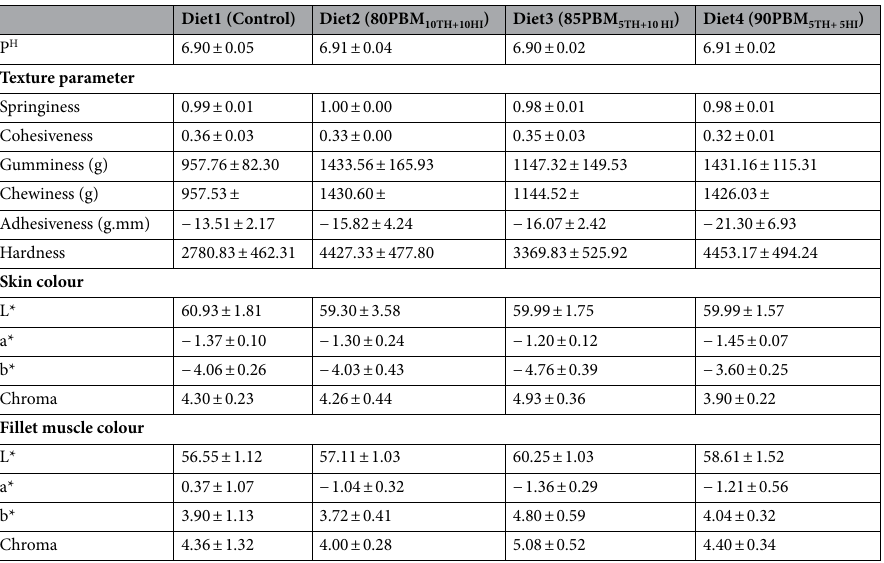
Table 6. Texture profile and colour of barramundi fillet after six weeks feeding with a gradient PBM diets, concurrently supplemented with TH and HI larvae meal. L*, light/dark; a*, red/green and b*,